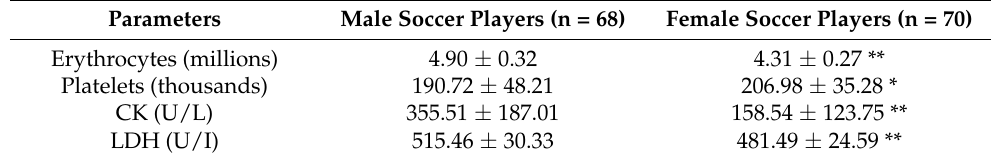
Table 4. Hematologic and biochemical values of the participants.